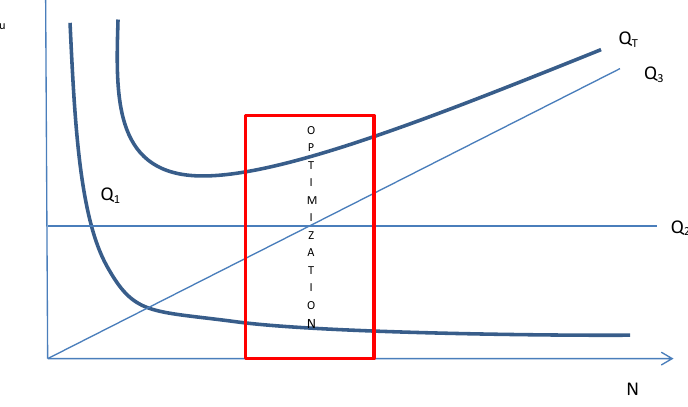
Figure 1. Cost diagram: unitary cost Q u , number of elements N